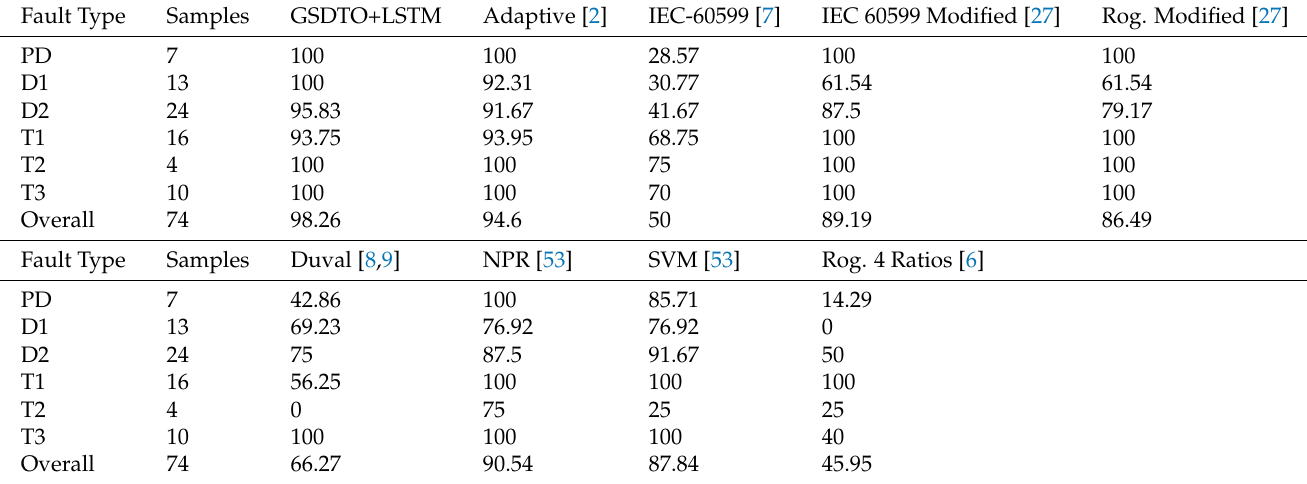
Table 14. The 74 testing samples diagnostic accuracy of the suggested algorithm compared to other